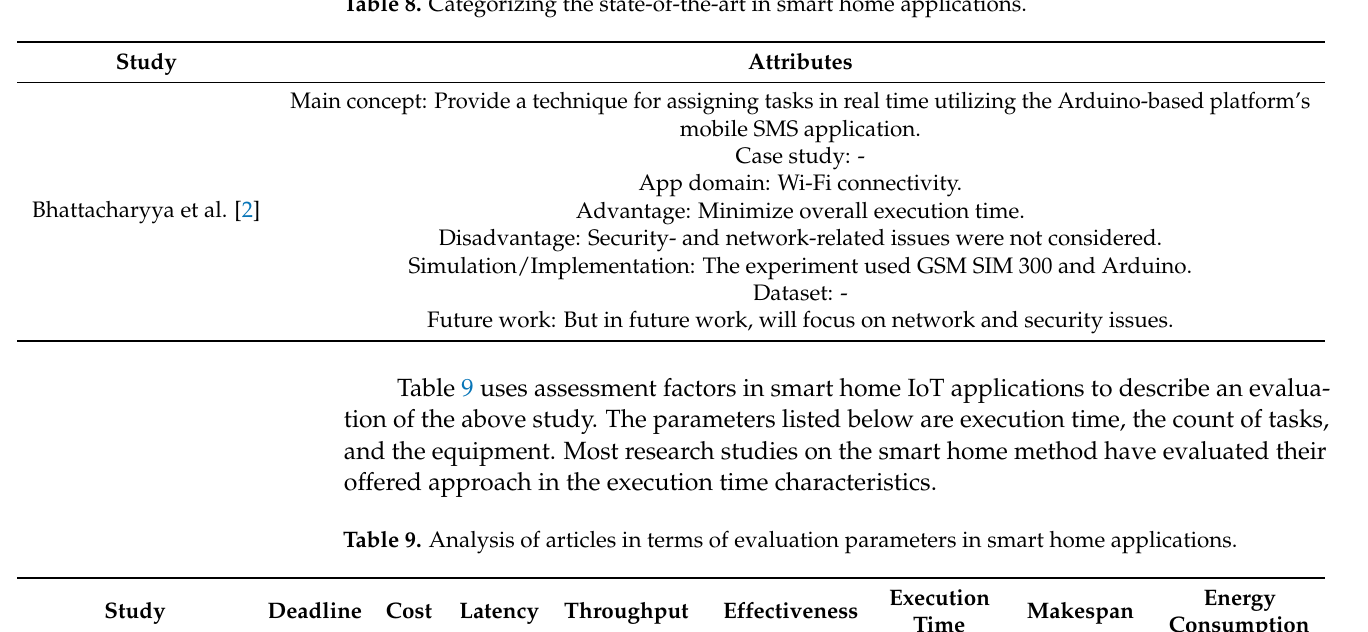
Table 8. Categorizing the state-of-the-art in smart home applications.